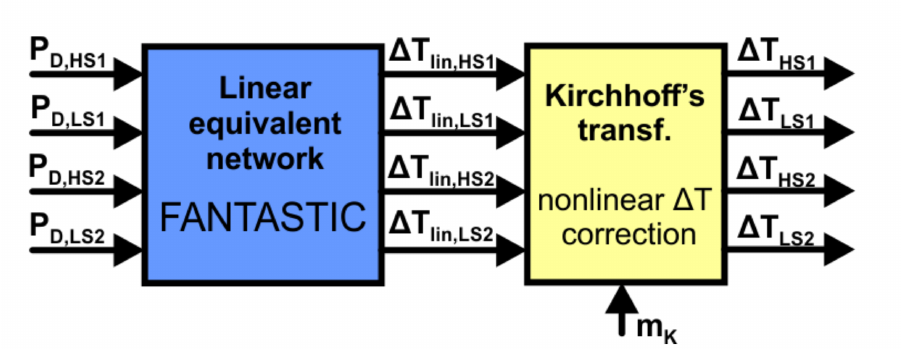
Figure 7. Sketch of the TFB comprising (i) the linear equivalent network automatically built by FANTASTIC (light blue box) and (ii) the nonlinear correction performed by the preliminarily tuned Kirchhoff’s transformation (light yellow).